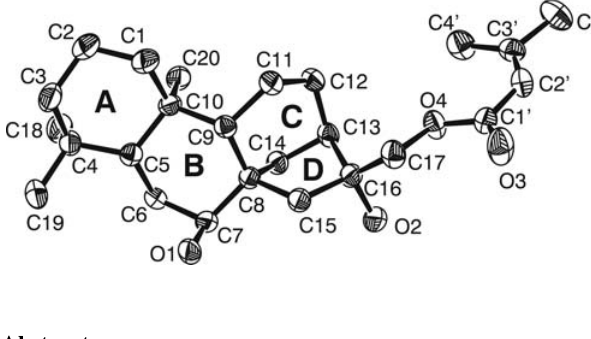
Table 1. Data collection and handling.